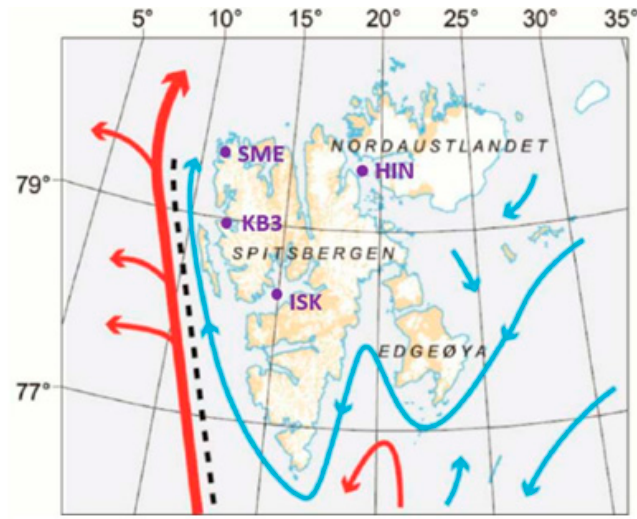
Figure 5. Map of the Svalbard archipelago, showing Atlantic water in the West Spitsbergen Current (red arrows), and Arctic water forming an Arctic coastal current (blue arrows). Dotted line indicates mixing between the two currents. ISK = Isfjorden; KB3 = Kongsfrorden; SME = Smeerenburgfroden; HIN = Hinlopen [15].